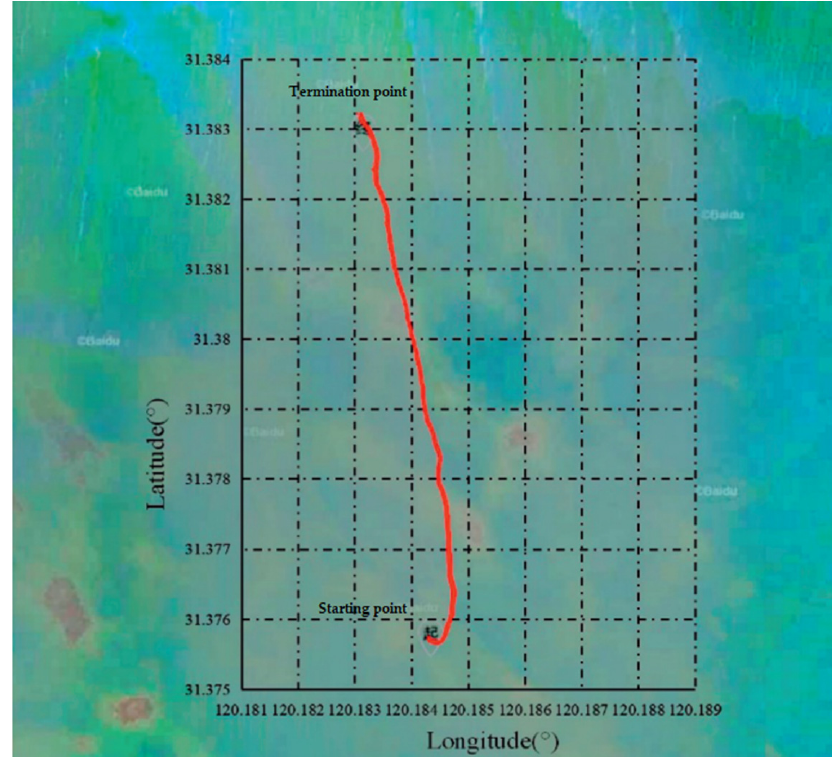
algorithm is within 0.7 m, while that of CKF and H ∞ CKF reach 6 m and 3.6 m, respectively, due to the appearance of outliers.